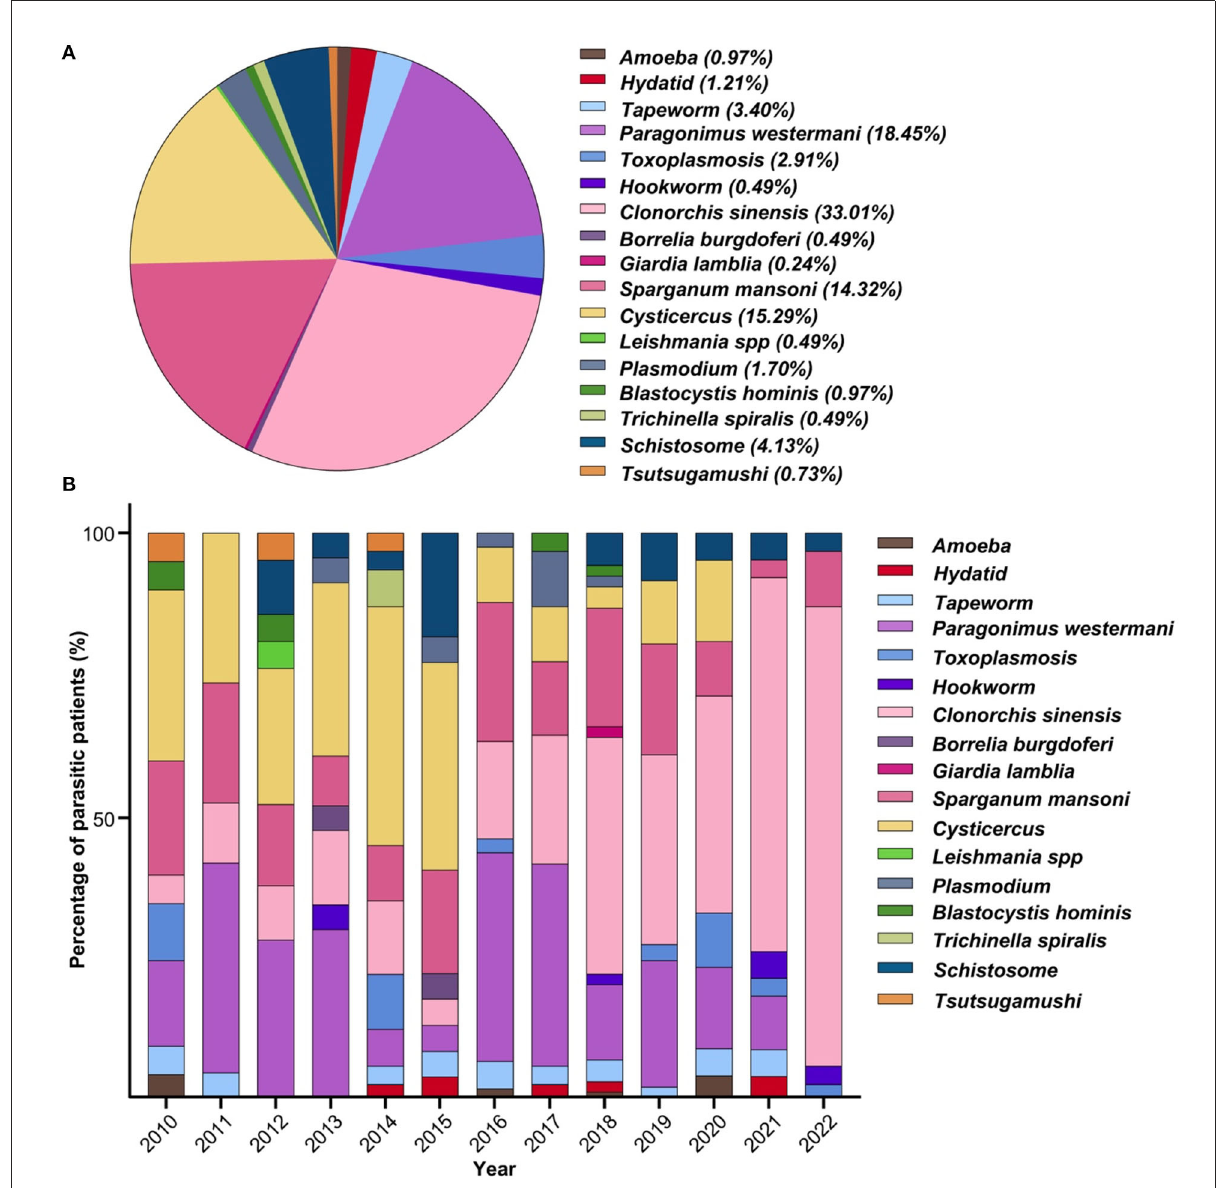
FIGURE4 Parasitic species and epidemic trend. (A) Constituent ratio of parasitic species. A total of 17 types of parasites were detected in patients. (B) Profile of every-year parasitic infections. Food-born parasites ( Clonorchis sinensis , Paragonimus westermani , Cysticercus , and Sparganum mansoni ) became the dominant parasitic species with rare infections of soil-transmitted